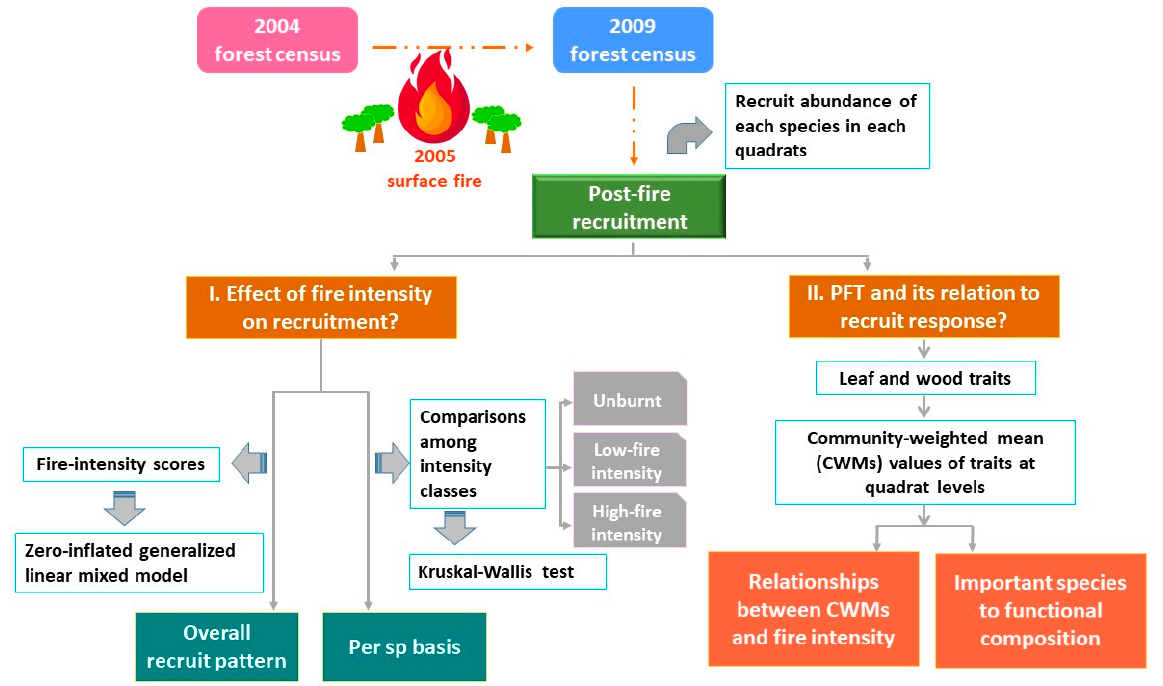
Figure 3. Overview of analysis workflow for the effect of 2005 surface fire influence post-fire recruit- ment in 2009, using data of tree recruitment data from the Forest Dynamics Plot, plant functional traits (PFT), and fire intensity scores.